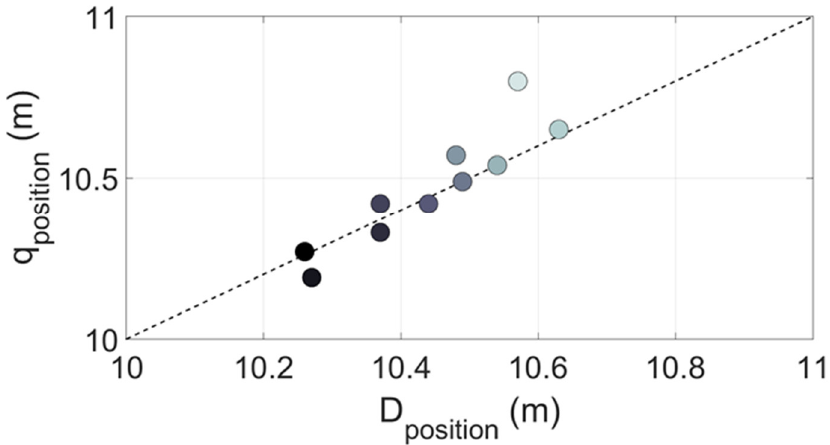
Figure 4. Comparison between the location of the (absolute) maxima in local sediment transport and the location of the peaks in wave energy dissipation. Colour code as above.